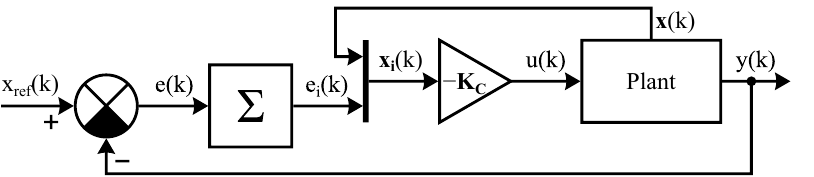
Figure 11. General schema of LQI controller.